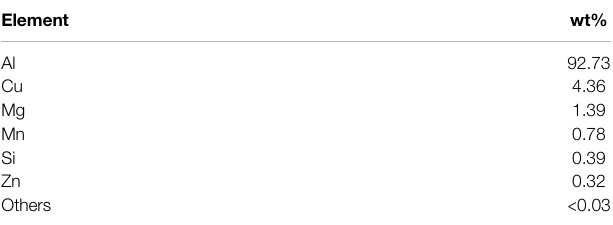
TABLE 1 | Compositions of the as received Al 2024 alloy by EDAX analysis.